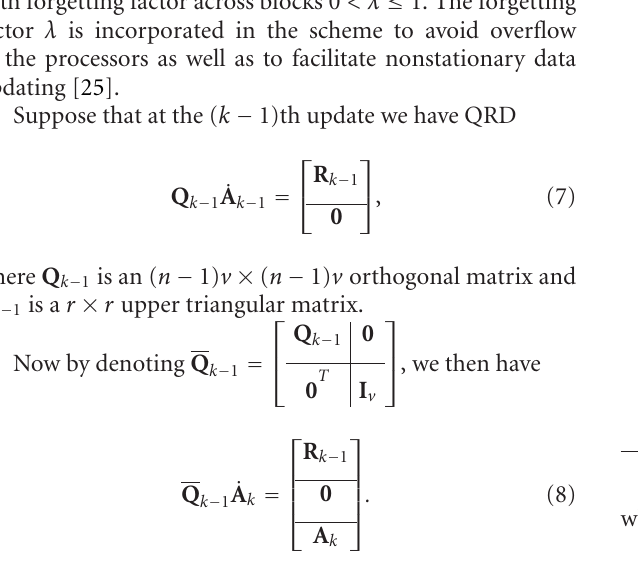
Table 1: CP-based Direct SBHT-RLS algorithm (CPE2). f ) ( f ) ... , y ( f ) v ) and Y Input: y ( k k , y k − 1 , k − 2 ( Known parameters: Γ i and σ i Selecting parameters: λ (with 0 < λ ≤ 1) Initialization: k = 0, an initial training process is used to initialize (cid:11) h = δ I (with 0 < δ (cid:9) 1 is small positive scalar). 0 and R 0 Algorithm: k = 1,2,3,